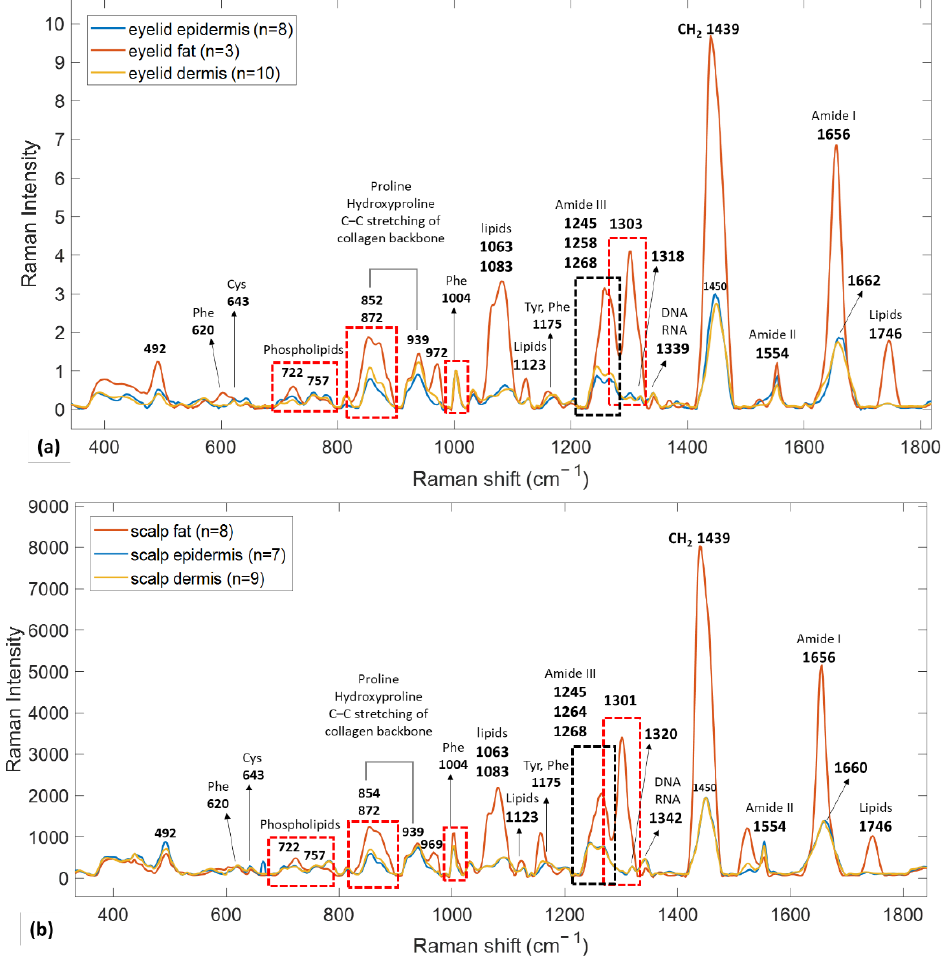
Figure 4. Typical Raman spectra of separate skin layers of ( a ) healthy human eyelid and ( b ) healthy human scalp. All spectra are baseline corrected and normalized to phenylalanine content, to help visualize changes between skin layers by enabling spectral comparison. Raman band assignments can be found in Table S1. Dashed boxes highlight areas of multiple bands assigned to vibrations of similar biomolecules.